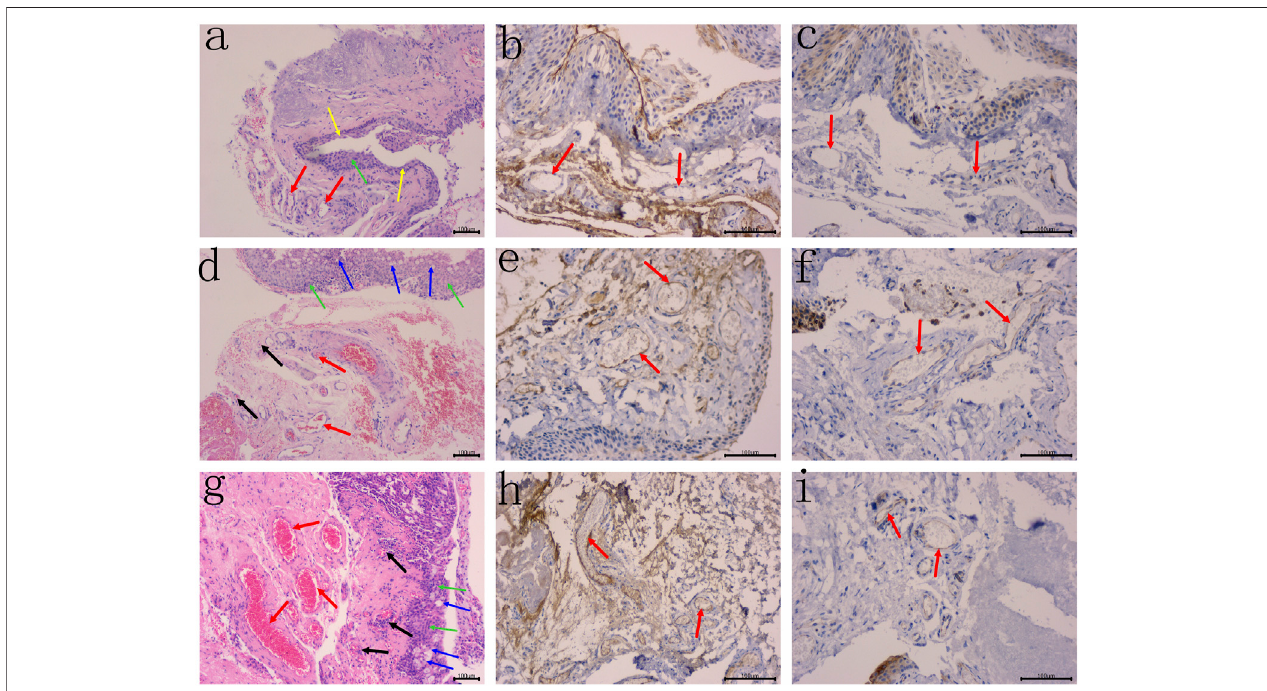
FIGURE 1 | The atrophy of epithelial cells (yellow arrows) and/or hyperplasia (green arrows), with the presence of increased goblet cells (blue arrows) were noted, distinct fi broblastproliferationwithmildin fl ammatorycellin fi ltrationwereobservedunderthemucosa. (A) HEstainingofhumanprimarypterygium(case15ingroup1)is demonstrated, the small vessels (red arrows) were observed, without evidence of capillary hyperplasia and vasodilation, original magni fi cation: 100 × . (B – C) Primary pterygiumspecimenwithnegativeVEGFandCOX-2expression,respectively.Nostainingreactioninthecytoplasmofvascularenothelialcells(redarrows),original magni fi cation: B – C 200 × . (D) HEstainingofhumanprimarypterygium(case9ingroup2)isdemonstrated,moderatecapillaryhyperplasiaindicatingangiogenesis(black arrows), and moderate vasodilation (red arrows) were noted, original magni fi cation: 100 × . (E – F) Primary pterygium specimen with moderate VEGF and COX-2 expression, respectively. Note the typical diffuse staining reaction in the cytoplasm of vascular endothelial cells (red arrows), original magni fi cation: E – F 200 × . (G) HE staining of human primary pterygium (case 37 in group 3) is demonstrated, capillary cluster hyperplasia indicating severe angiogenesis (black arrows), and severe vasodilation (red arrows) were observed, original magni fi cation: 100 × . (H – I) Primary pterygium specimen with high VEGF and COX-2 expression, respectively. Note the typical diffuse staining reaction in the cytoplasm of vascular endothelial cells (red arrows), original magni fi cation: H – I 200 × .